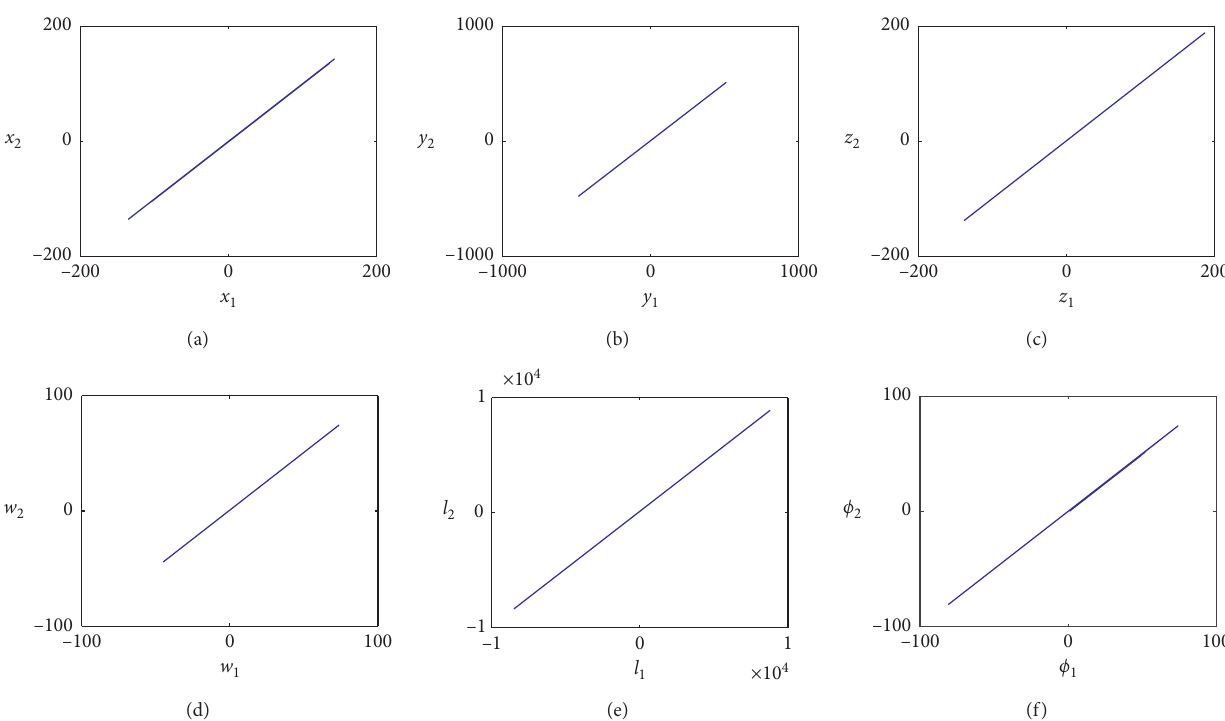
Figure 13: Synchronous phase diagram of two different structure systems in the corresponding plane. (a) x − w − l , (e) l , and (f) φ (d) w 1 2 1 2